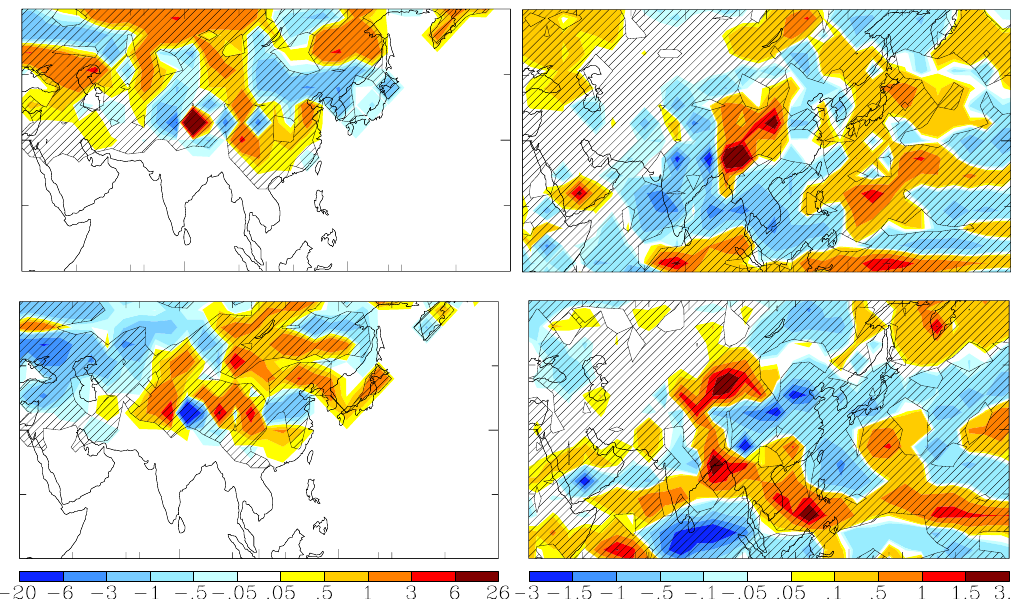
Fig. 8. Average difference in annual snow/ice cover (%) (left panel) and June-July-August precipitation (mm/d) (right panel). The top panels represent differences due to black carbon used in the Beig and Bond emissions for present-day (Emissions from year 2000 are considered as present-day since these are the most current full suite of emission inventories available for the chemistry model). The bottom panels represent future changes (from 2000 to 2010) from black carbon for the Beig emissions. Simulations represented are (D+I+SA) C . Differences that are significant at the 95% confidence level are indicated by hatched areas.